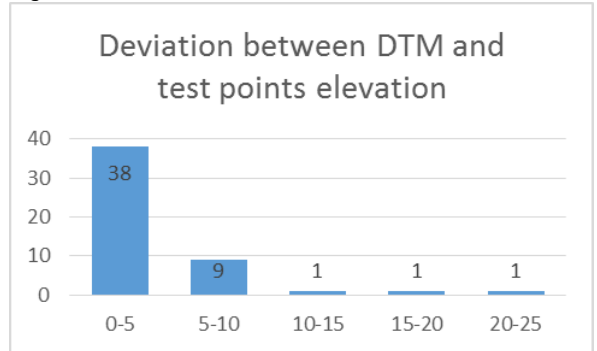
Figure 6. The deviation between DTM and test points elevation The deviation between elevation in the stereo model and DTM is used to calculate RMSE and LE90. LE90 is used to determine the vertical accuracy. Validation refers to Head of Geospatial Information Agency Rules Number 15 Year 2014 about Base